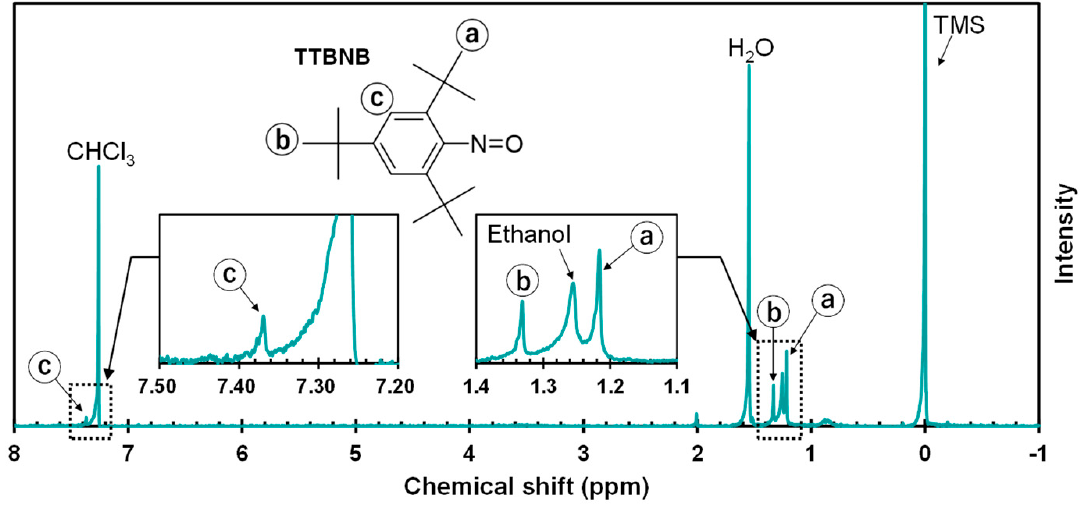
Figure 4. 1 H-NMR spectra of a CDCl 3 extracted solution of PP granules (PP-H) after scCO 2 treat- ment. Table 4. Correlated TTBNB concentration determined by 1 H-NMR characteristic peak integrals. Peak Integral (a.u.) TTBNB Sample